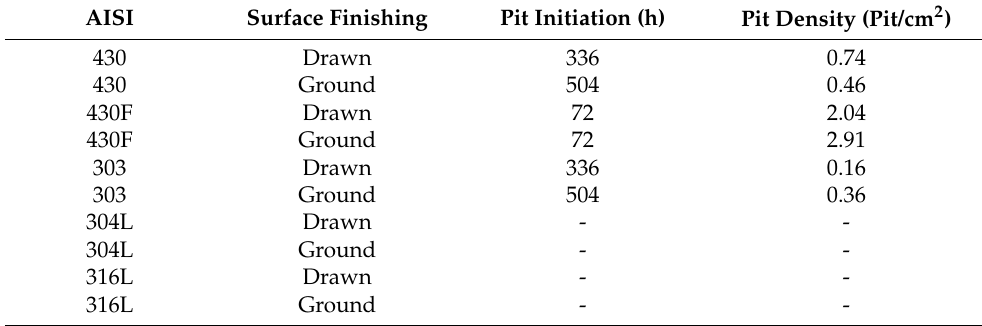
Table 7. Pitting initiation times and pit density at the end of the salt spray corrosion test.